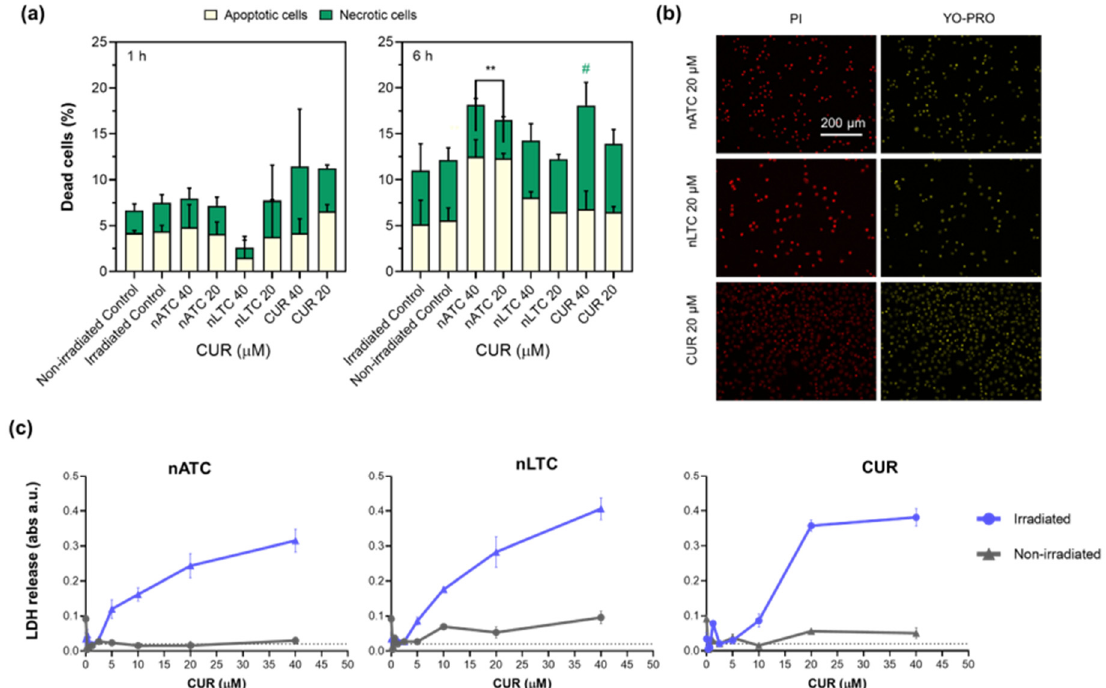
Figure 5. Death mechanisms induced by PDT. A549 cell line was incubated with nATC, nLTC, or free CUR and irradiated (fluence of 9 J/cm 2 ) or kept in the dark (non-irradiated). ( a ) 1 and 6 h after irradiation cells were incubated with Annexin V and PI. Significant differences compared with apoptotic control cells were determined using a one-way ANOVA followed by Dunnet’s test, ** p < 0.01. Significant differences compared with necrotic non-irradiated control cells were determined using a one-way ANOVA followed by Dunnet’s test, # p < 0.05. After 24 h incubation ( b ), cells were stained with YO-PRO and IP and ( c ) LDH release in cells supernatants was measured.